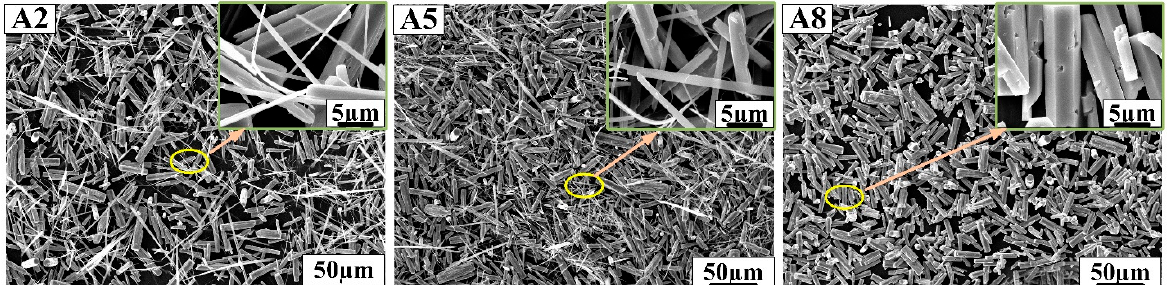
Figure 3. SEM morphology of samples A2, A5 and A8 prepared in nitric acid solution.